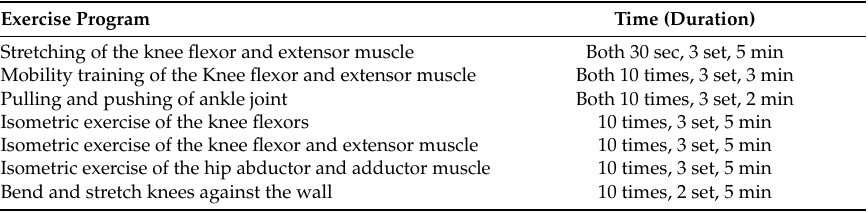
Figure 1. Visual feedback-based dynamic balance exercise program. Table 1. Conventional physical therapy program.